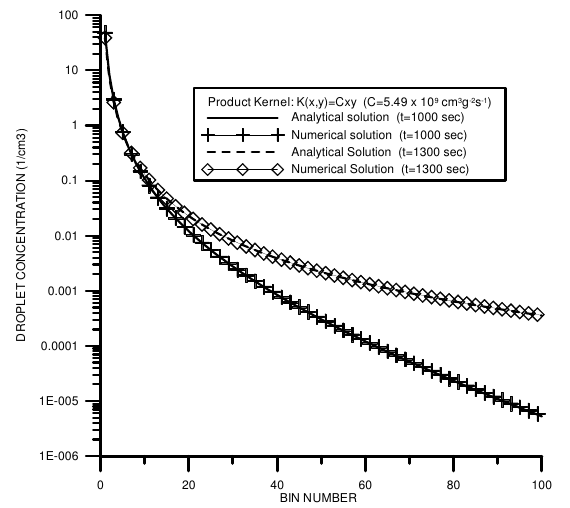
Figure 4. Time evolution of the liquid water content (first moment of the distribution) Fig. 4. Time evolution of the liquid water content for the product kernel ( K(x,y)=Cxy, C =5.49×10 10 cm 3 g -2 s -1 ), calculated from the (first moment of the distribution) for the product kernel numerical solution of the KCE. ( K(x,y)=Cxy, C =5.49 × 10 10 cm 3 g − 2 s − 1 ), calculated from the numerical solution of the